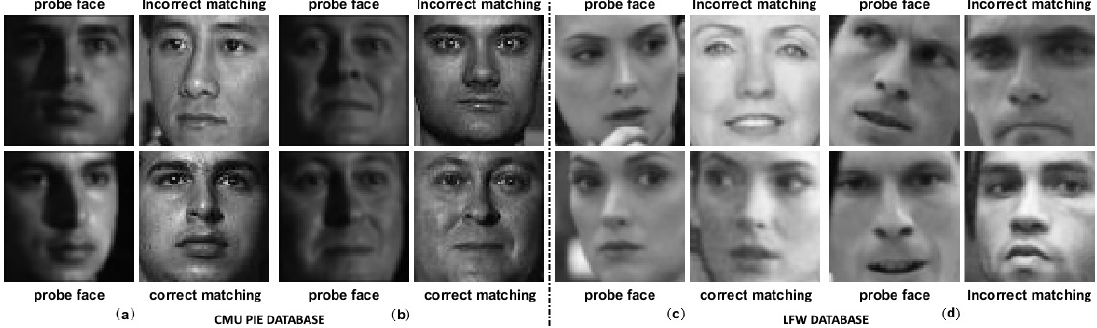
Figure 6. Incorrect vs. correct matching.( a , b ): CMU PIE; ( c , d ):